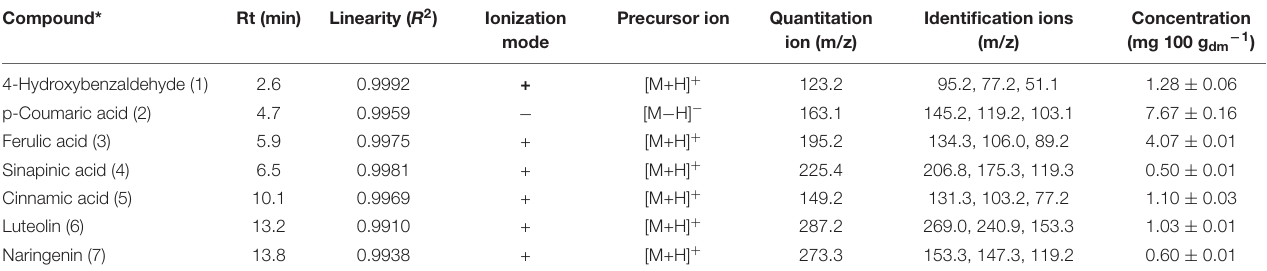
TABLE 6 | Analytical parameters and concentration of main polyphenols identified in the DP extract under optimal MAE conditions ( n = 3, mean ± SD). Compound* Rt (min)